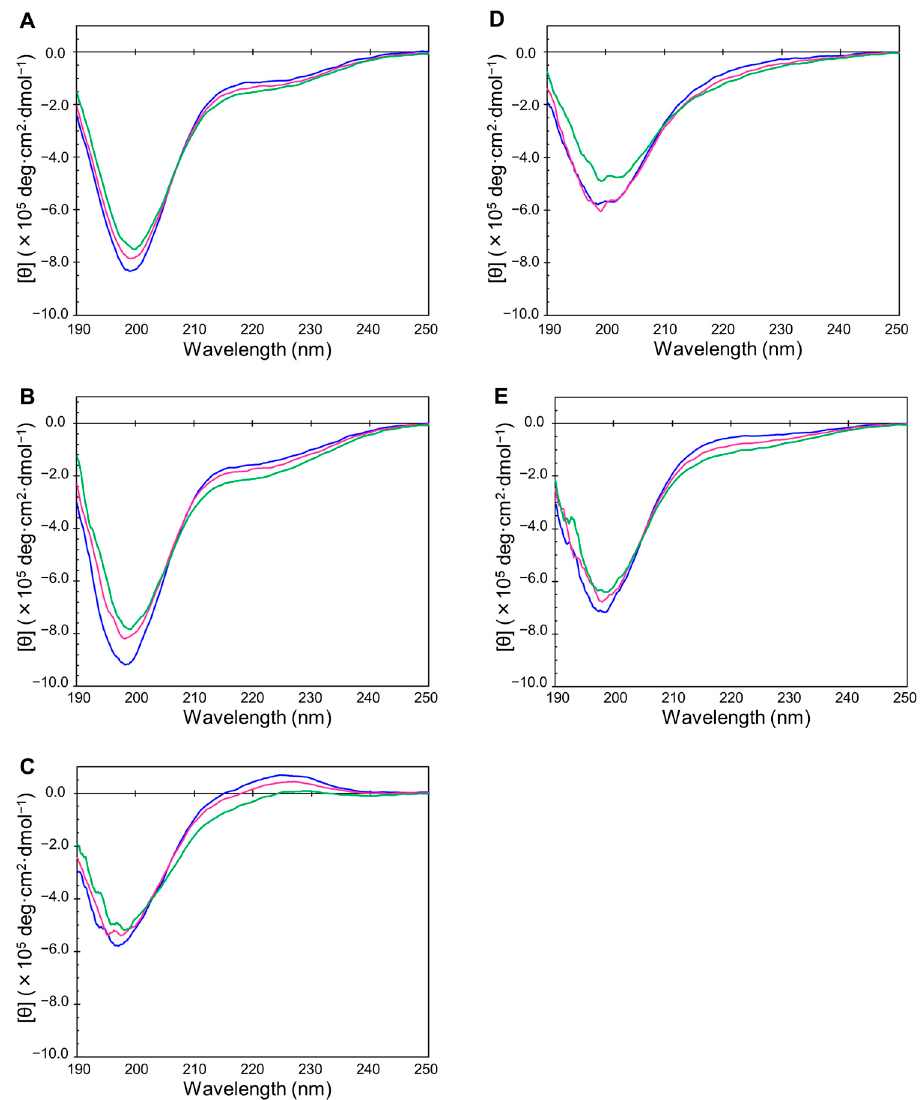
Figure 1. Circular dichroism (CD) spectra of the selected human genome-derived intrinsically disordered protein (IDP) samples. Spectra were measured at 5 °C (navy), 20 °C (red), and 35 °C (green). ( A ) IDP-B3; ( B ) IDP-B4; ( C ) IDP-C1; ( D ) IDP-D10; ( E ) IDP-E1.